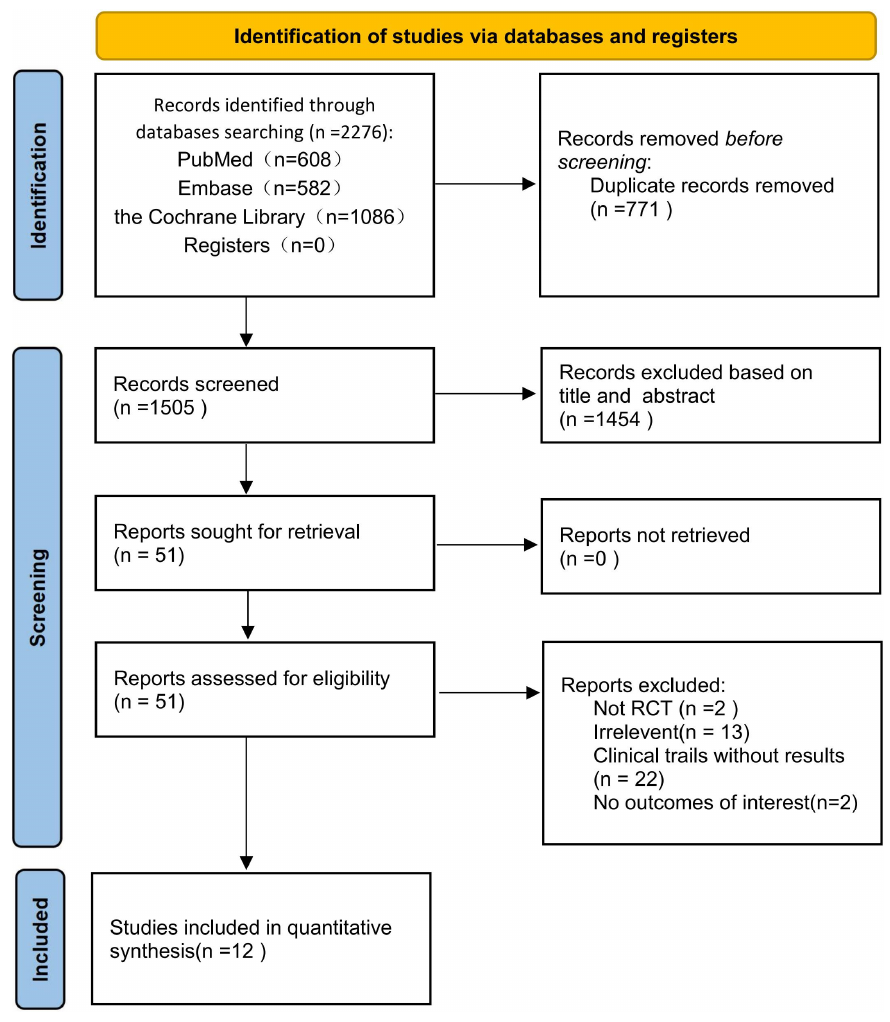
Figure 1. Flow chart of study identification and selection.